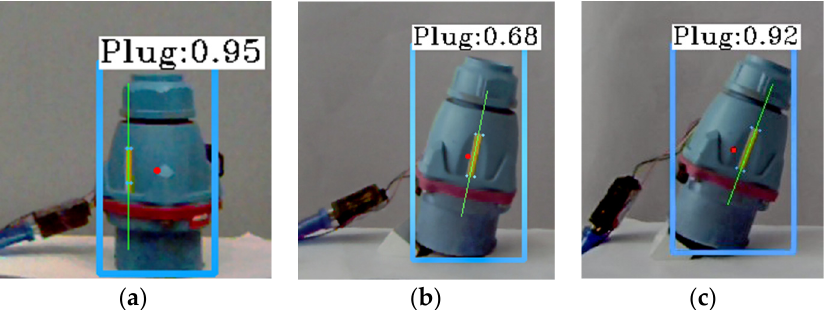
Figure 8. State measurement schematic diagram under three situations. ( a ) Rotate about Y C axis. ( b ) Rotate about Z C axis. ( c ) Rotate about Y C and Z C